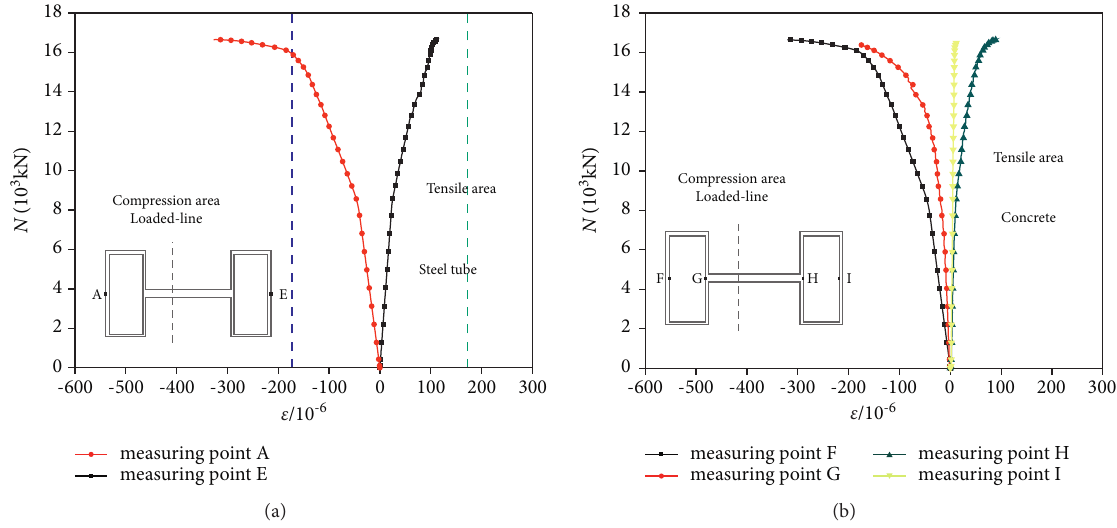
Figure 14: N - ε curves for STHCC-1. (a) N - ε curves for steel tube. (b) N - ε curves for